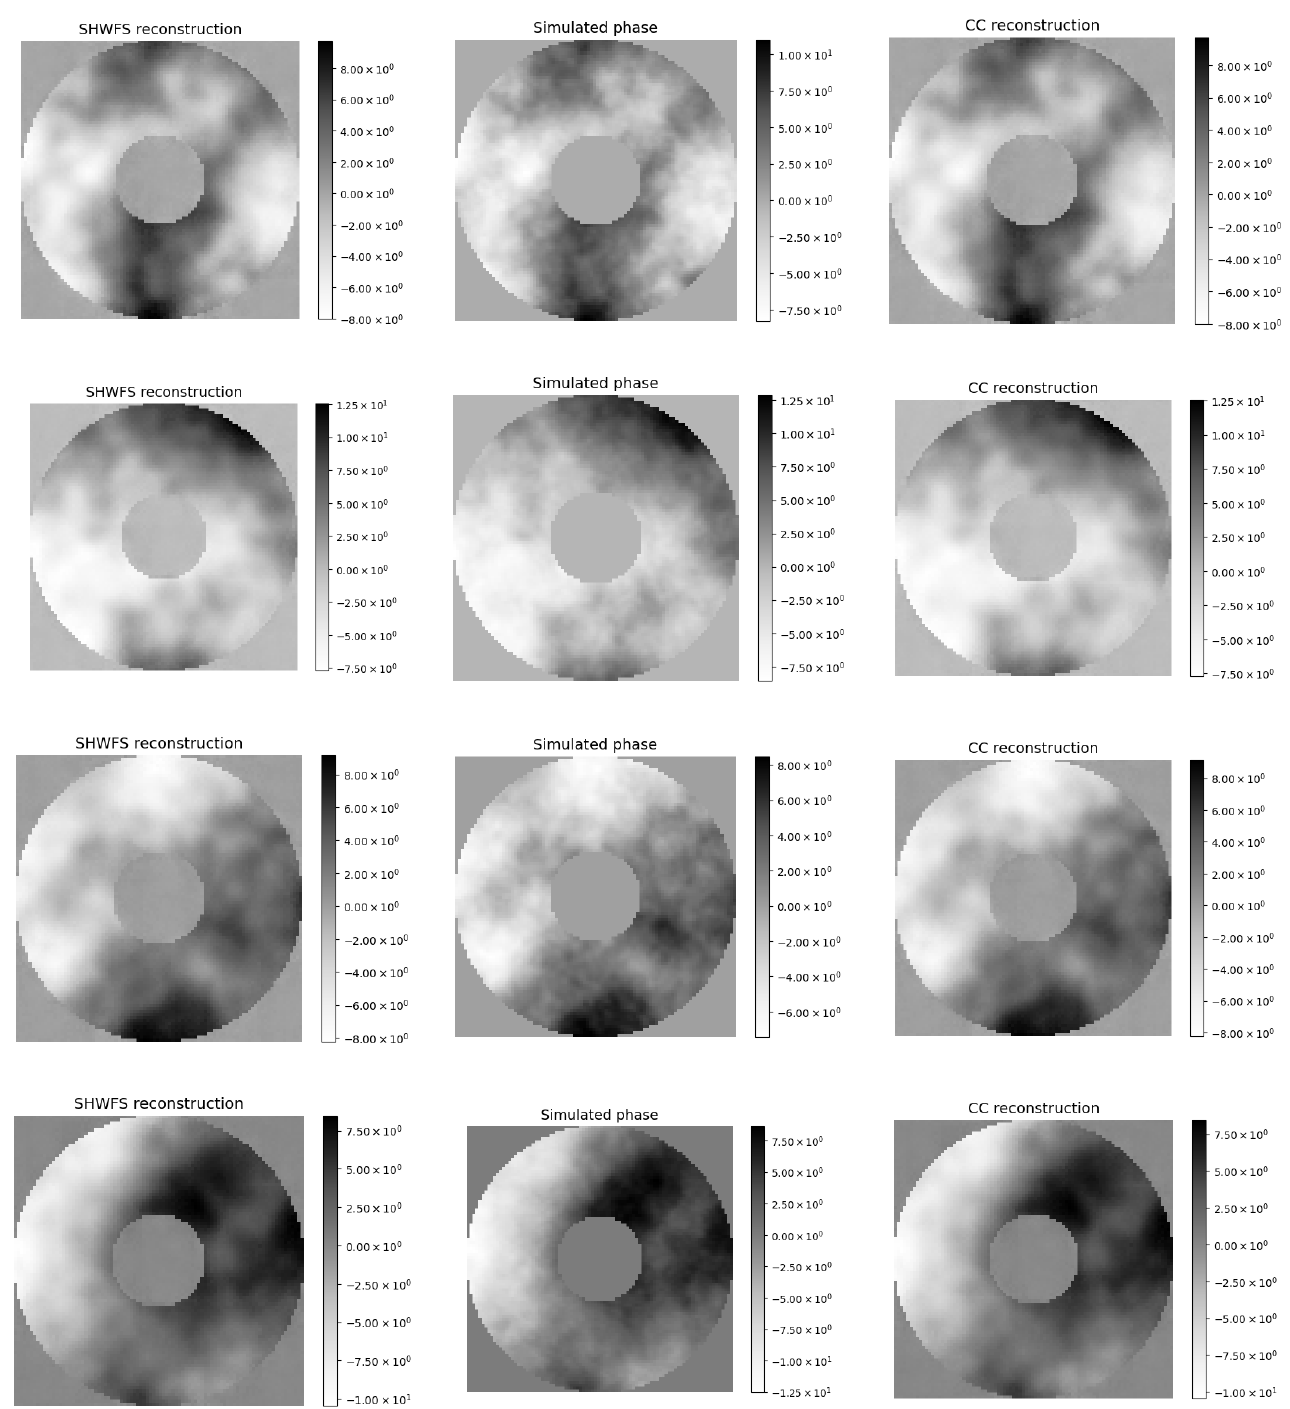
Figure 5. Comparison of the reconstructed phases for high-altitude layer turbulences with the original one. Each row corresponds to an example of a sample of each test dataset used, with r 0 values from 7 to 17 cm in steps of 2 cm, and its corresponding reconstructions. The images are placed following the order presented in Figure 4.